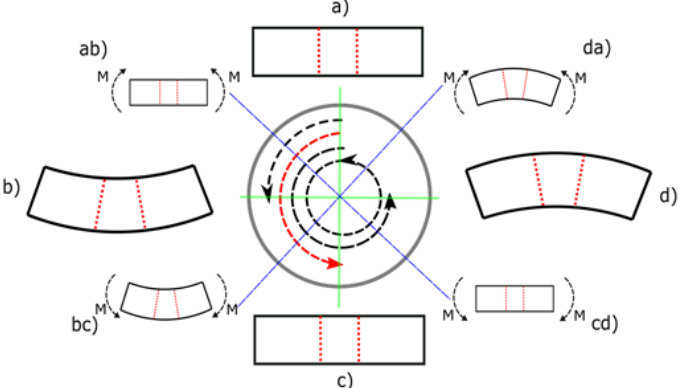
Figure 2. Graphical representation of the cyclic deformation.